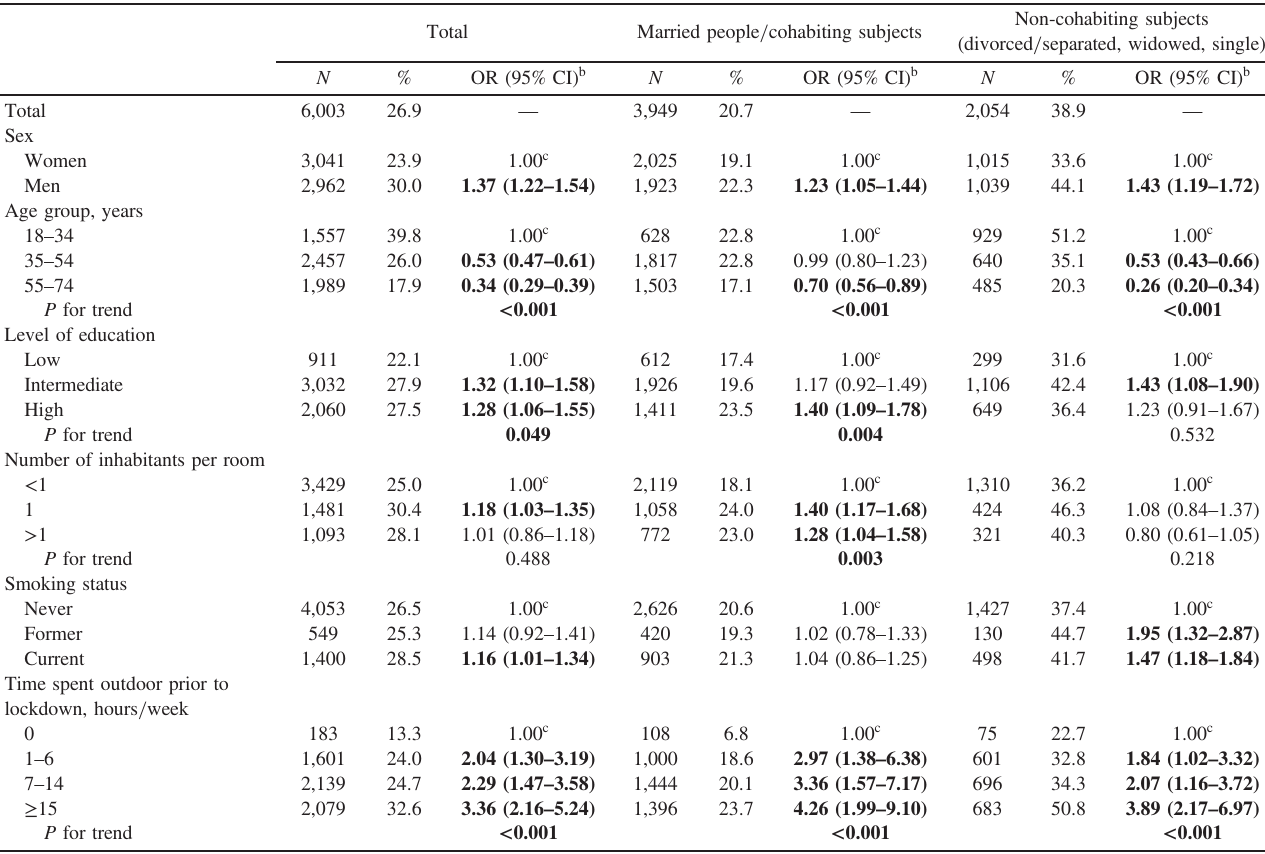
Married people = cohabiting